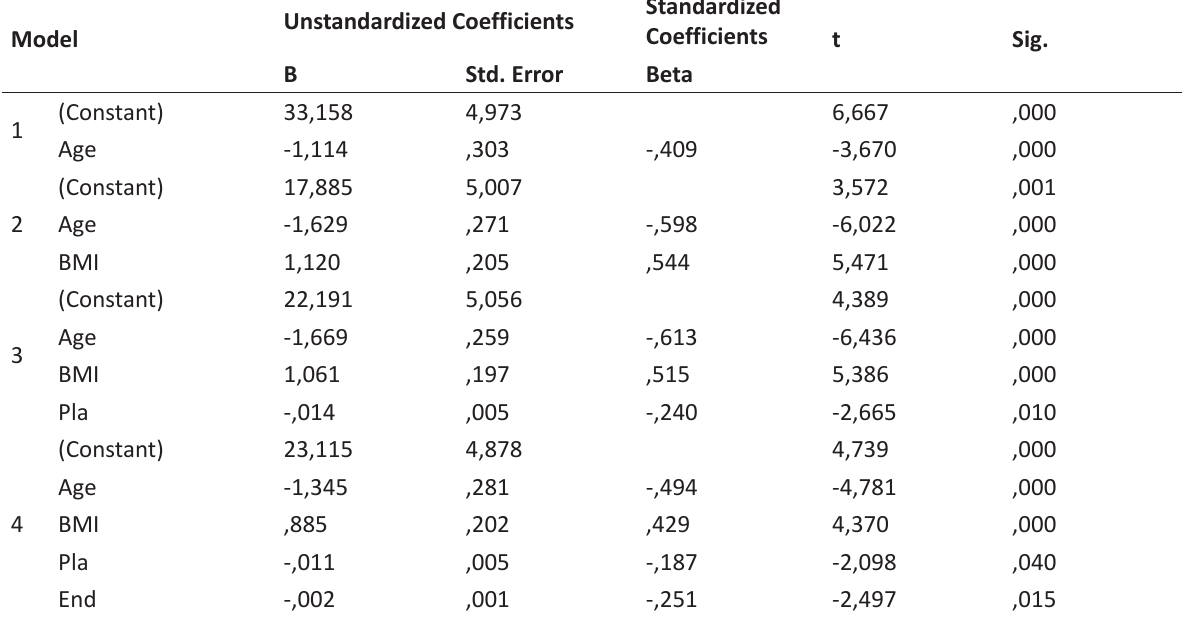
Table 4. Coefficients